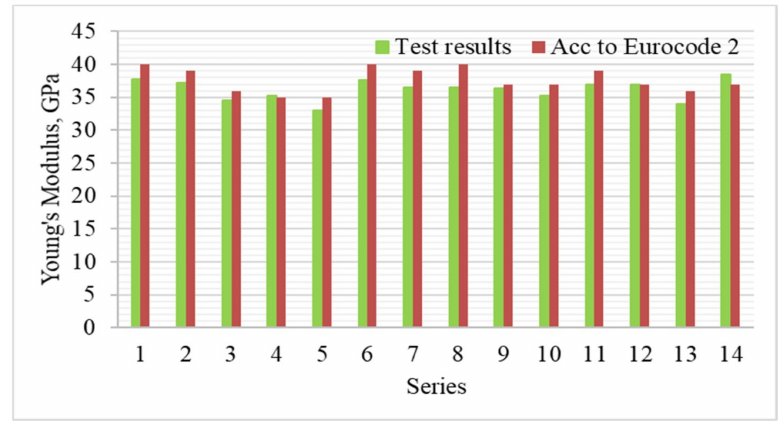
Figure 10. The comparison of the results of Young’s Modulus with standard results according to EN 1992-1-1 [23].